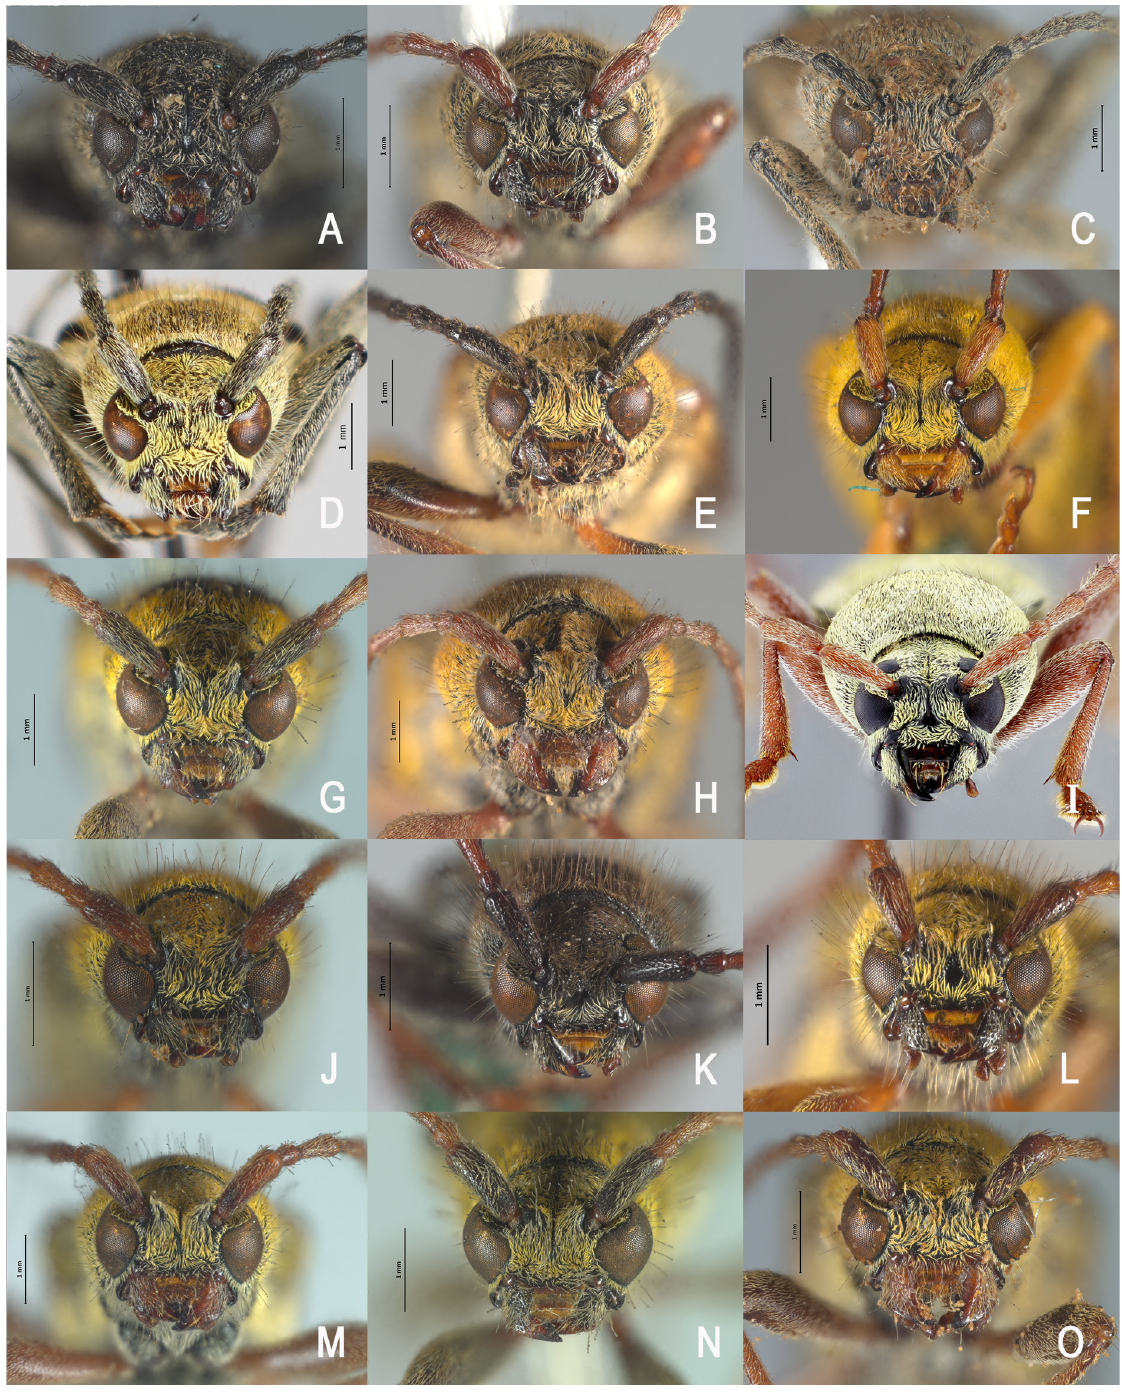
Fig. 4. Head, frontal view of type species of Ochraethes . A . Ochraethes brevicornis (Chevrolat, 1860), ♀. B . O . virescens (Chevrolat, 1860), ♂. C . O . cinereolus (Bates, 1892) comb. nov., ♀. D . O . octomaculata Chemsak & Noguera, 2001, ♂. E . O . obliquus (Chevrolat, 1860), ♂. F . O . zebratus Bates, 1885, ♀. G . O . sommeri (Chevrolat, 1835), ♂. H . O. circuliferus (Chevrolat, 1860) (= Ochraethes sommeri ), ♀. I . Trichoxys giesberti Botero et al. , 2019, ♀. J . O . viridiventris (Chevrolat, 1860), ♂. K . O . nigritus Bates, 1892 (= Ochraethes viridiventris ), ♂. L . O . clerinus Bates, 1892, ♀. M . O . z-littera (Chevrolat, 1860), ♂. N . O . cristoforii (Chevrolat, 1860), ♂ . O . O . litura Bates, 1885,